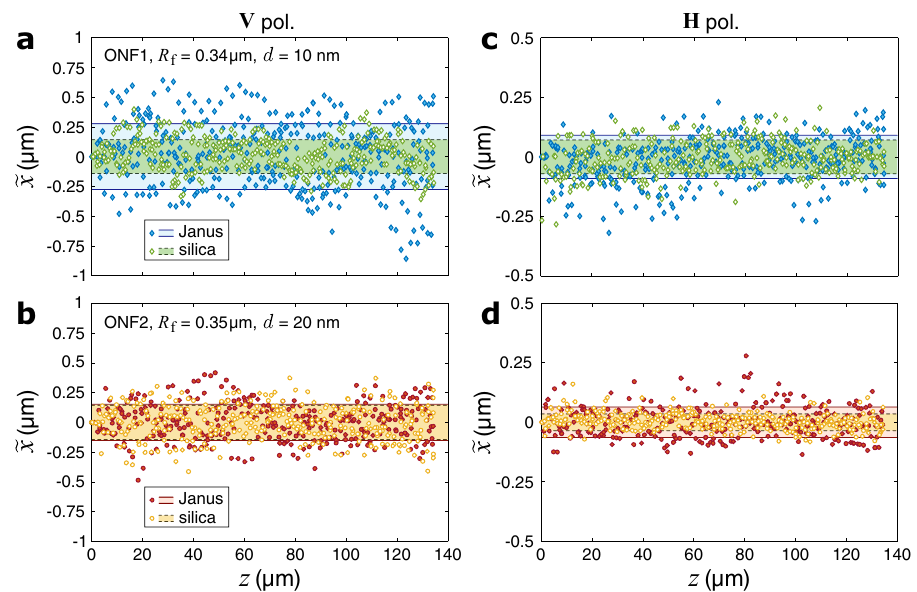
Fig. 6 | Optical trapping dynamics of Janus and silica particles propelled by lightnear anONF. (Supplementary Movie 3) a , b Typical reduced trajectories ofa JP compared to a SP in the same sample, with the ONF coupled to beam 1 with